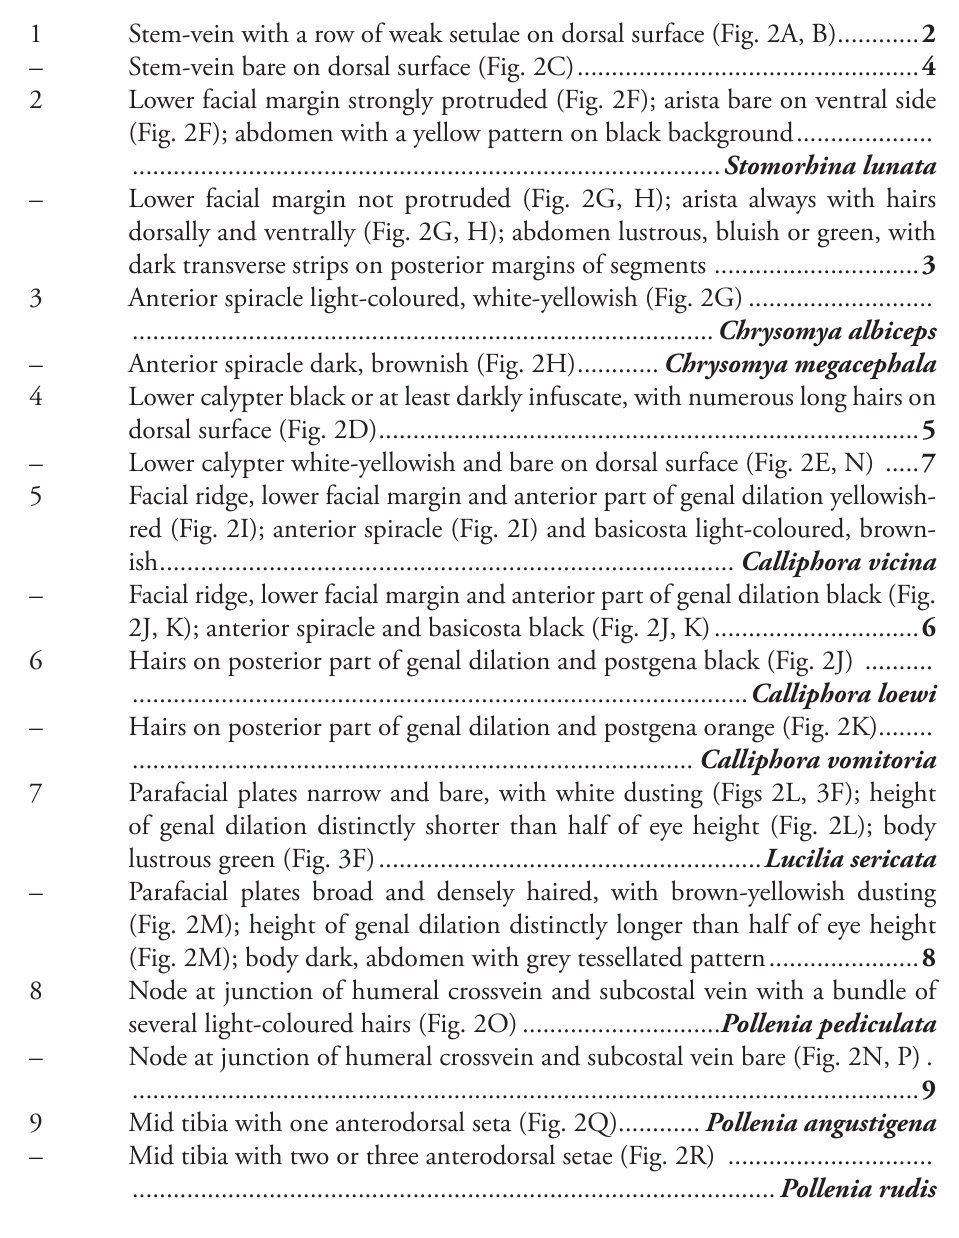
1 Stem-vein with a row of weak setulae on dorsal surface (Fig. 2A, B) ............ 2 – Stem-vein bare on dorsal surface (Fig. 2C) .................................................. 4 2 Lower facial margin strongly protruded (Fig. 2F); arista bare on ventral side (Fig. 2F); abdomen with a yellow pattern on black background .................... – Lower facial margin not protruded (Fig. 2G, H); arista always with hairs dorsally and ventrally (Fig. 2G, H); abdomen lustrous, bluish or green, with dark transverse strips on posterior margins of segments .............................. 3 3 Anterior spiracle light-coloured, white-yellowish (Fig. 2G) ........................... – Anterior spiracle dark, brownish (Fig. 2H) ............ Chrysomya megacephala 4 Lower calypter black or at least darkly infuscate, with numerous long hairs on dorsal surface (Fig. 2D) ............................................................................... 5 – Lower calypter white-yellowish and bare on dorsal surface (Fig. 2E, N) ..... 7 5 Facial ridge, lower facial margin and anterior part of genal dilation yellowish- red (Fig. 2I); anterior spiracle (Fig. 2I) and basicosta light-coloured, brown- ish .................................................................................... Calliphora vicina – Facial ridge, lower facial margin and anterior part of genal dilation black (Fig. 2J, K); anterior spiracle and basicosta black (Fig. 2J, K) .............................. 6 6 Hairs on posterior part of genal dilation and postgena black (Fig. 2J) .......... – Hairs on posterior part of genal dilation and postgena orange (Fig. 2K)........ 7 Parafacial plates narrow and bare, with white dusting (Figs 2L, 3F); height of genal dilation distinctly shorter than half of eye height (Fig. 2L); body lustrous green (Fig. 3F) ........................................................ Lucilia sericata – Parafacial plates broad and densely haired, with brown-yellowish dusting (Fig. 2M); height of genal dilation distinctly longer than half of eye height (Fig. 2M); body dark, abdomen with grey tessellated pattern ...................... 8 8 Node at junction of humeral crossvein and subcostal vein with a bundle of several light-coloured hairs (Fig. 2O) ............................. Pollenia pediculata – Node at junction of humeral crossvein and subcostal vein bare (Fig. 2N, P) . 9 Mid tibia with one anterodorsal seta (Fig. 2Q)............ Pollenia angustigena – Mid tibia with two or three anterodorsal setae (Fig. 2R)